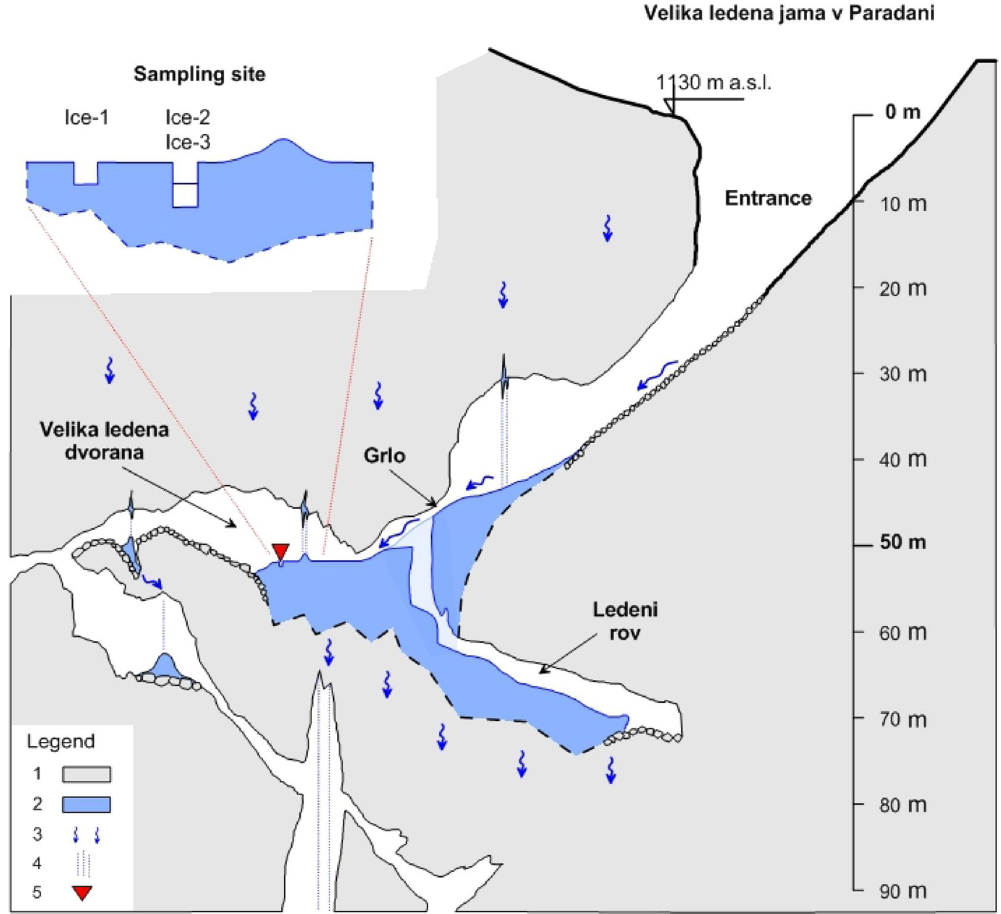
Figure 4. Paradana Ice Cave showing sampling site location (1-limestone, 2-ice, 3-water flow, 4-percolation water, 5-sampling